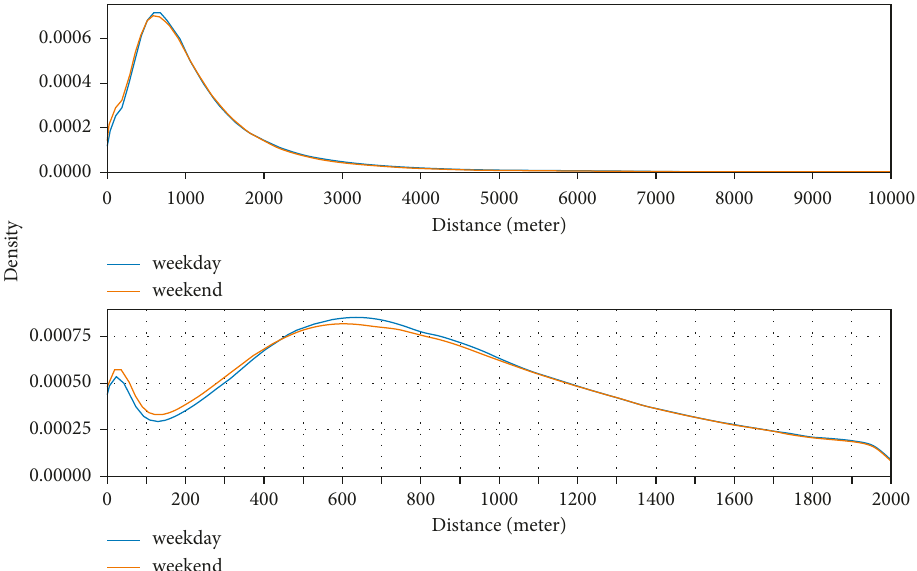
Figure 6: The estimated probability density function of DLBS travel distance.